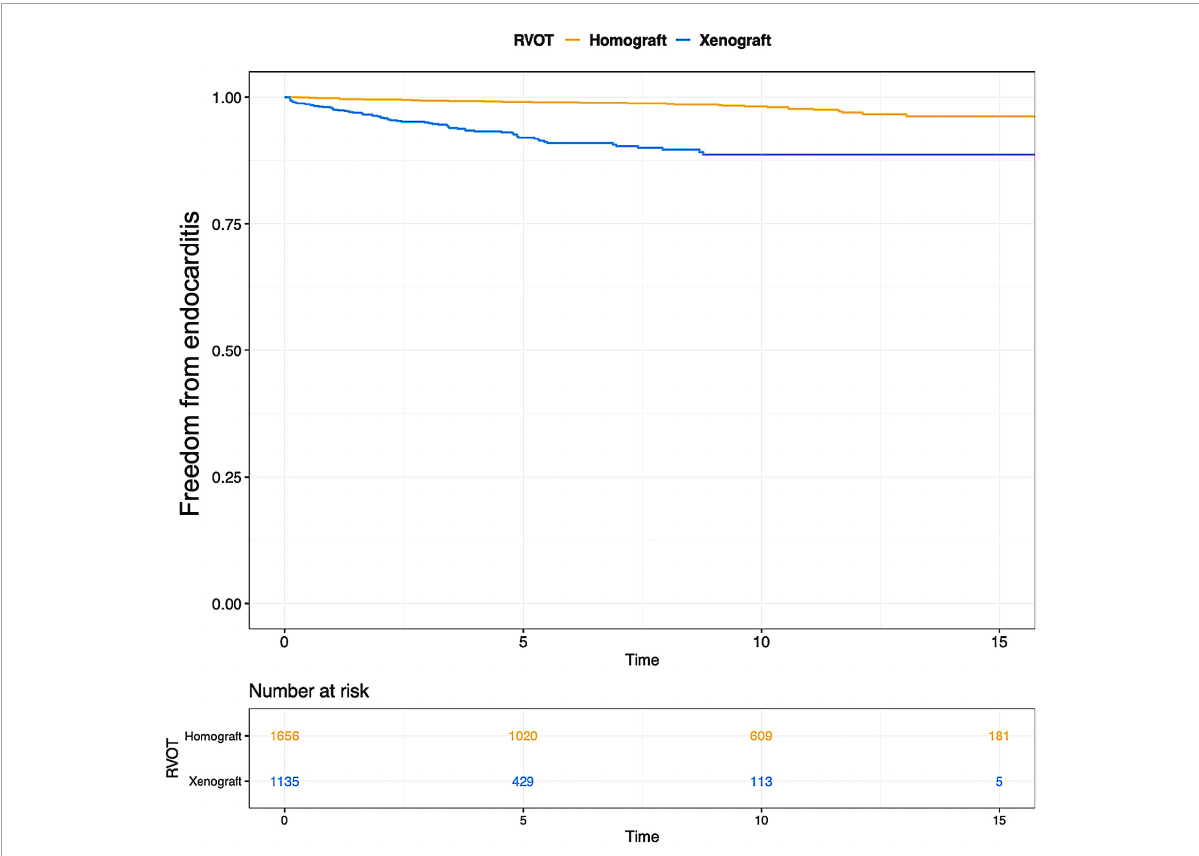
FIGURE5 Pooled Kaplan-Meier curves of freedom from endocarditis of two subgroups: RVOT reconstruction with xenograft and homograft. The blue line stands for xenograft and the yellow line stands for